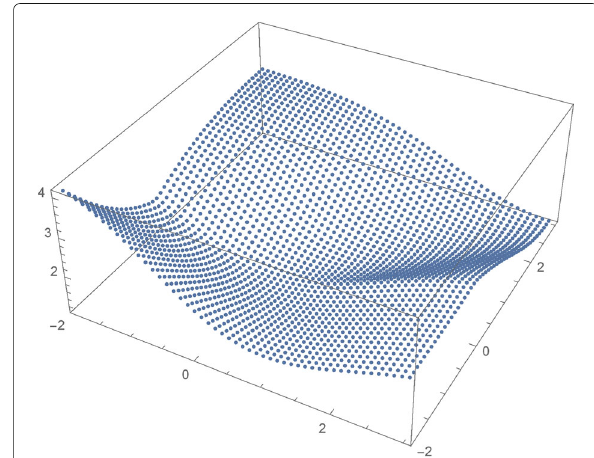
Fig. 10 Variance of the procurement cost V [ C ]